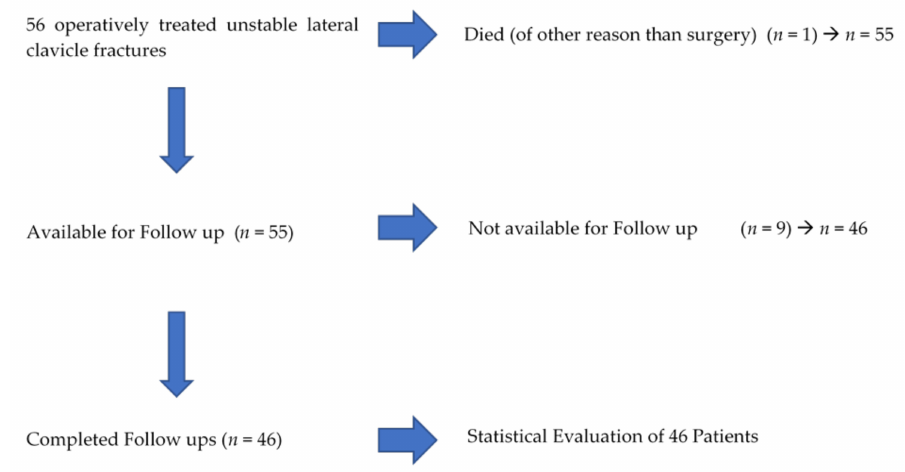
Figure 3. Flow chart of included/excluded patients.